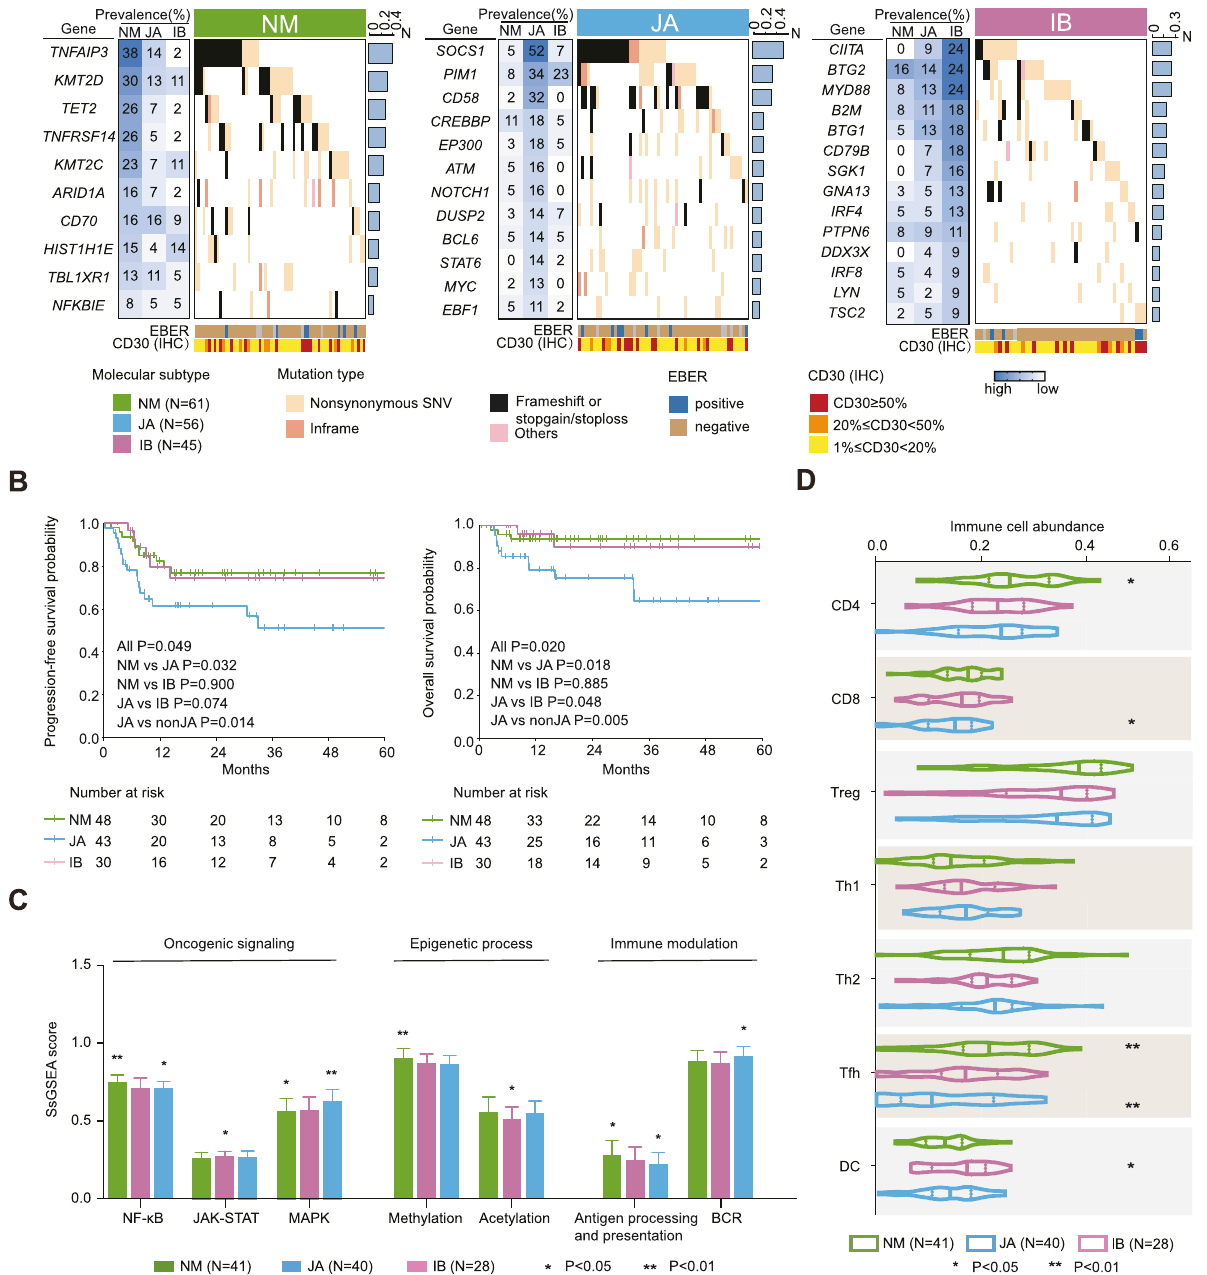
Fig. 2 CD30 + DLBCL molecular subtypes with prognostic signi fi cance and therapeutic implication. A Genetic composition of CD30 + DLBCL molecular subtypes. The prevalence of the indicated genetic features was indicated at the left. Column represent each DLBCL patient with information of CD30 expression estimated by immunohistochemistry and EBER. B Kaplan – Meier curves for progression-free survival (left panel) and overall survival (right panel) according to three molecular subtypes. C Single sample Gene-Set enrichment analysis (ssGSEA) score of signature genes in each molecular subtype. Top graph shows annotated pathways into three major classes (oncogenic signaling, epigenetic process and immune modulation). P value was calculated between certain molecular subtype versus other subtypes of CD30 + DLBCL. Error bars denote SD. D In fi ltration score of indicated immune cells in each molecular subtype. P value was calculated between certain molecular subtype versus other subtypes of CD30 +